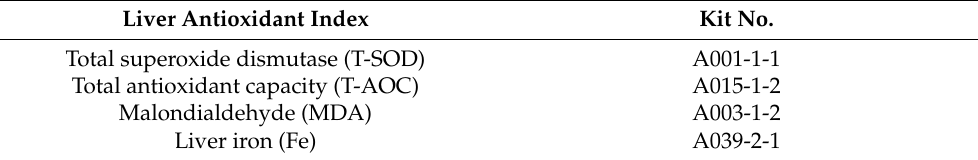
Table 3. The liver antioxidant index with the corresponding commercial kit number. Liver Antioxidant Index Kit No.